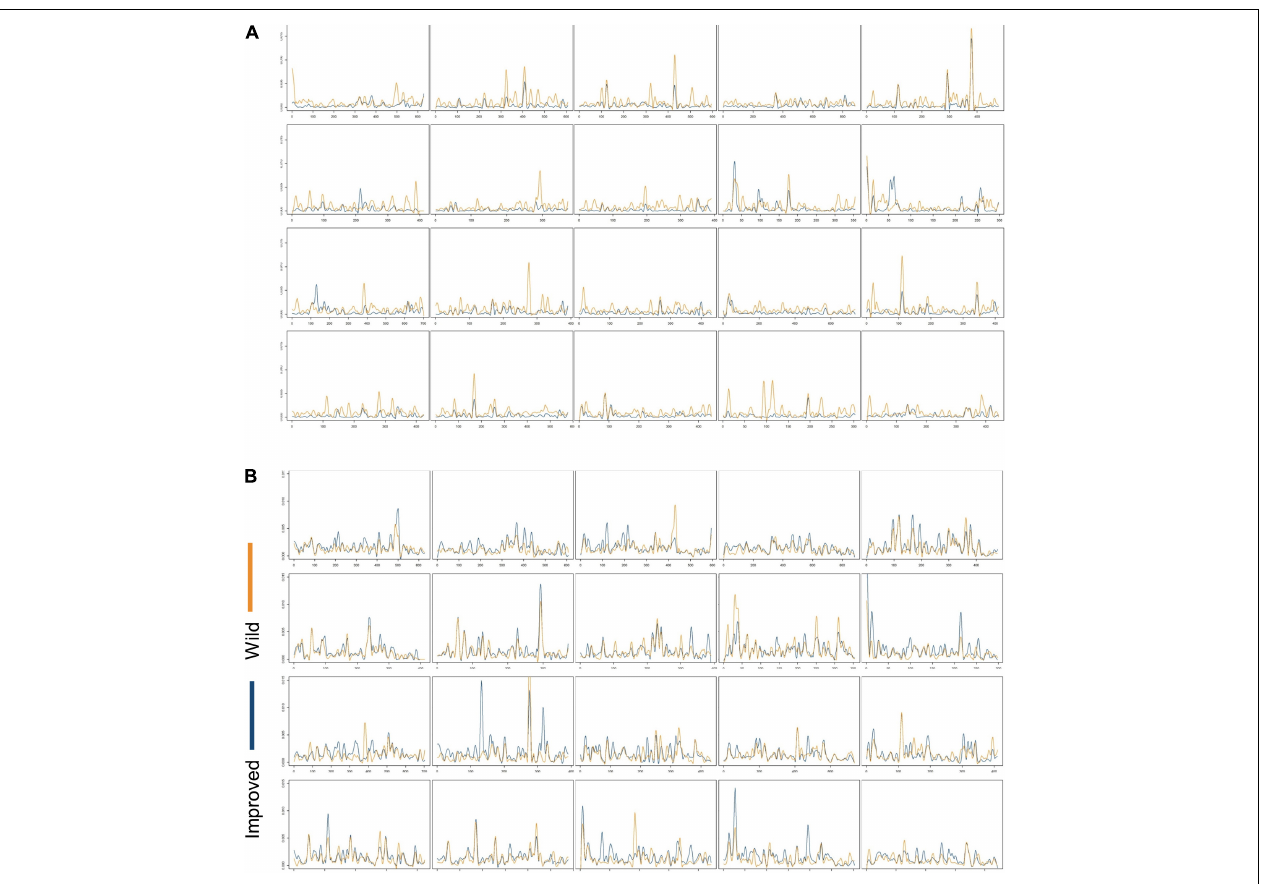
FIGURE 5 | By-locus values of within-population nucleotide diversity ( θ w) for improved (blue) and wild (orange) “populations” across chromosomes 1–20 in (A) Cucurbita argyrosperma and (B) Cucurbita maxima .